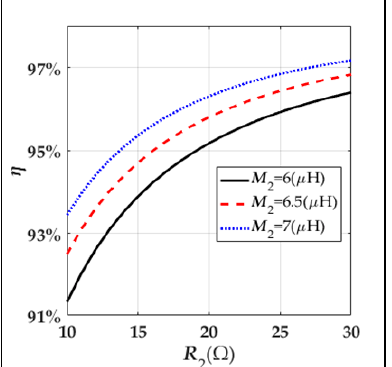
Figure 8. The variation of the efficiency η with the mutual inductance and the load in Mode B.